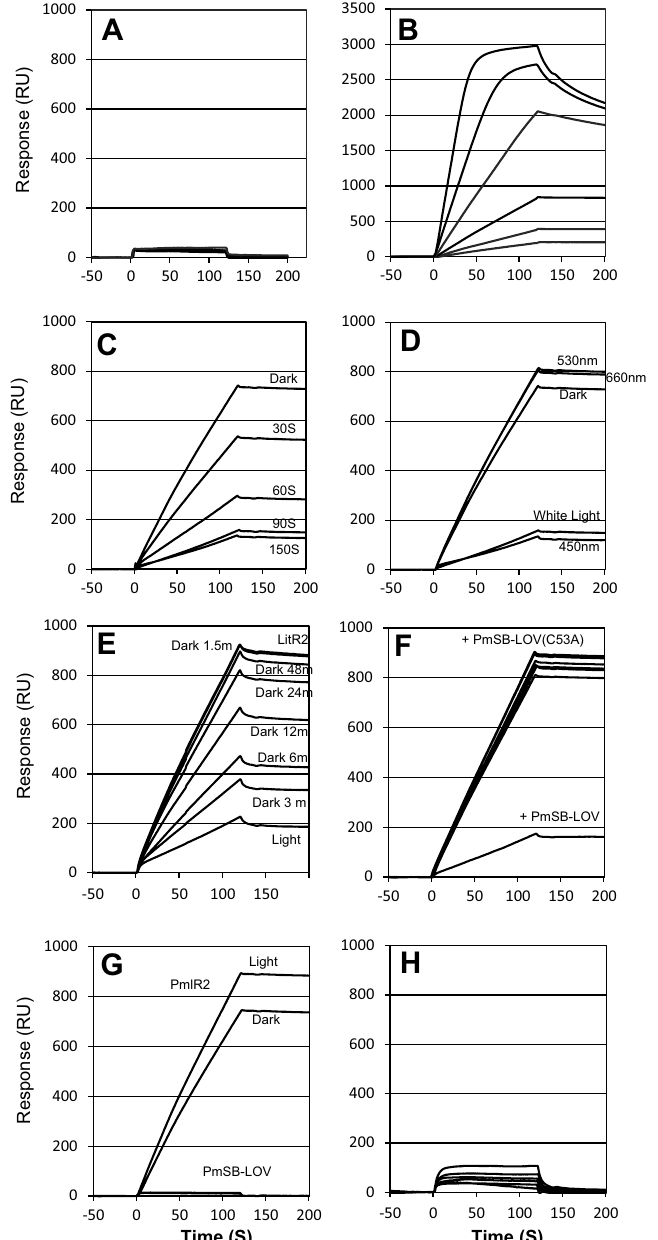
Figure 7. BIAcore analysis. Immobilized DNA on the surface of the sensor chip included P 468 as a negative control ( A ), PmlR2-binding Site 2 ( B )–( G ), and the mutated PmlR2-binding Site 2 ( H ). Injected proteins were 8.6 to 275.2 nM PmlR2 ( A , B and H ), 34.4 nM PmlR2 and 292.3 nM PmSB-LOV ( C – E , and G ), 34.4 nM PmlR2 and 292.3 nM PmSB-LOV C53A ( F ). Samples were irradiated with blue light (λ max = 450 nm), green light (λ max = 530 nm), and red light (λ max = 660 nm) at 100 µmol m −2 s −1 for the indicated times. Two independent experiments in technical replicates were performed, and representative data were